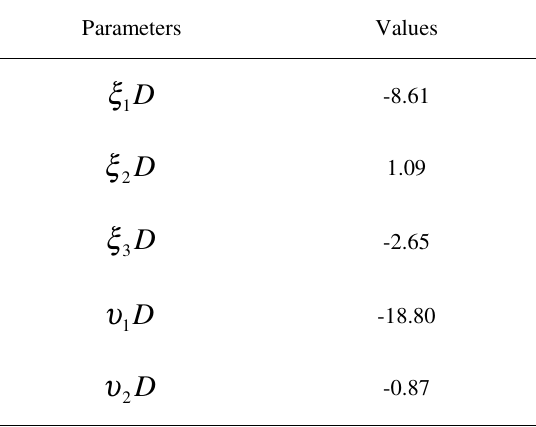
Table 3 Values of third-order potential parameters (in G Pa) of